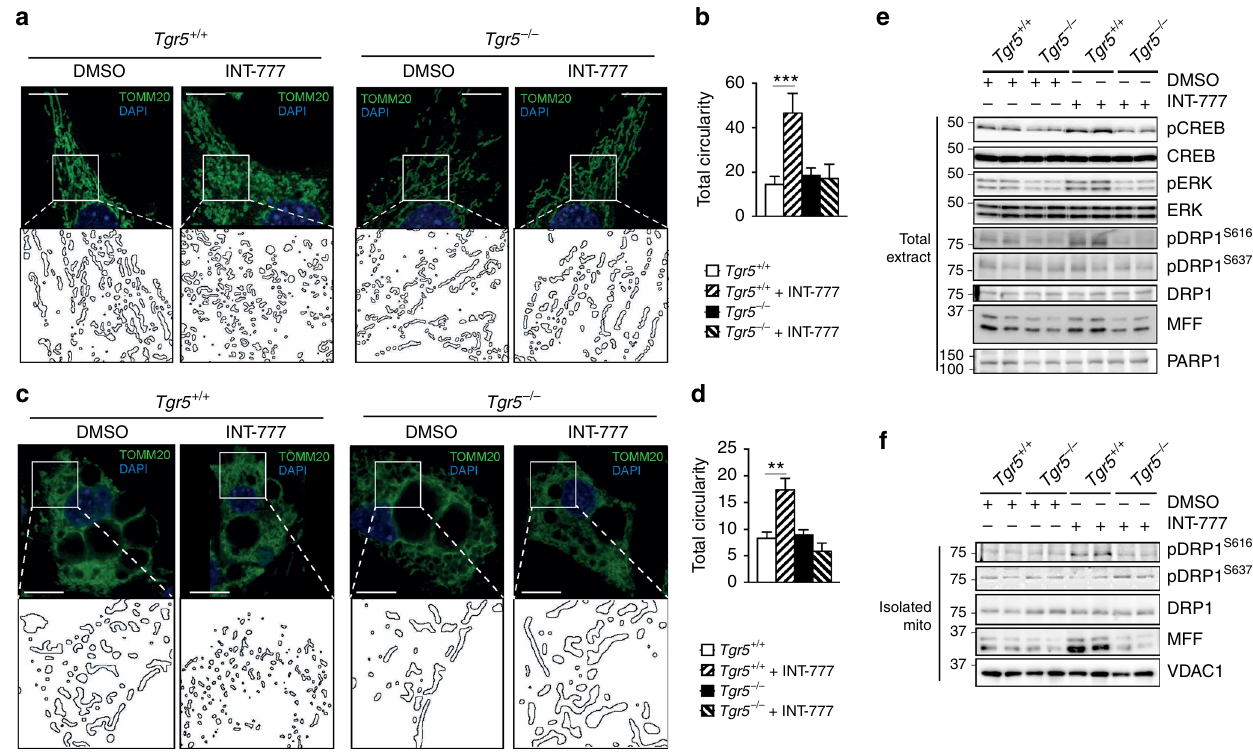
Fig. 6 TGR5 activation induces mitochondrial fi ssion in an ERK-DRP1-dependent manner. a , c Representative ( n = 6 per group) images of TOMM20 immuno fl uorescence (in green) on preadipocytes ( a ) and differentiated adipocytes ( c ) derived from the stromal vascular fraction (SVF) of TGR5 wild-type ( Tgr5 + / + ) and germline TGR5 knockout ( Tgr5 − / − ) mice and stimulated with the TGR5 agonist INT-777 or vehicle (DMSO). Nuclei were stained with DAPI (in blue). Scale bars = 10 μ m ( a ) 25 μ m ( c ). Insets show higher magni fi cation of the reconstructed mitochondrial network (ImageJ program). b , d Quanti fi cation of mitochondrial circularity from images as in a and c calculated with ImageJ. n = 6. e , f Representative ( n = 6 per group) western blots of TGR5 downstream targets (phospho proteins), their relative controls (CREB, ERK and DRP1) and the mitochondrial protein MFF from the total extract ( e ) or isolated mitochondria ( f ) derived from differentiated adipocytes described in c . PARP1 ( e ) and VDAC1 ( f ) were used as loading controls. n = 6. Results represent mean ± SEM. ** P ≤ 0.01 and *** P ≤ 0.001 vs. Tgr5 + / + cells by one-way ANOVA followed by Bonferroni post hoc test. Uncropped western